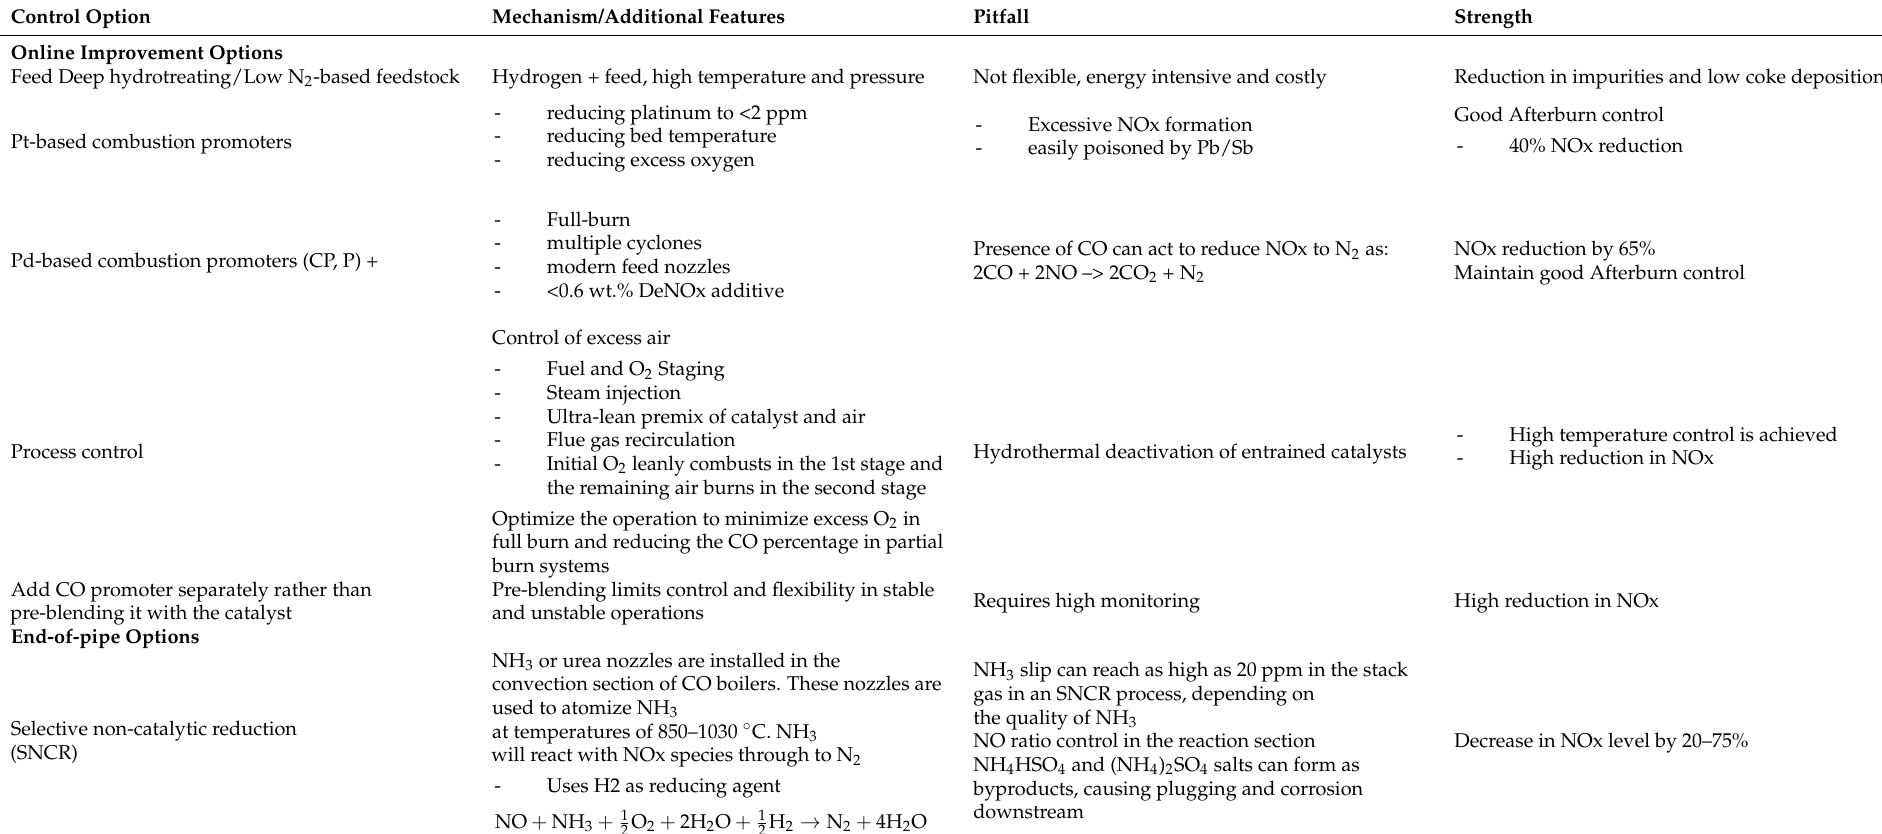
Table 10. Operational and Structural mitigation of NOx